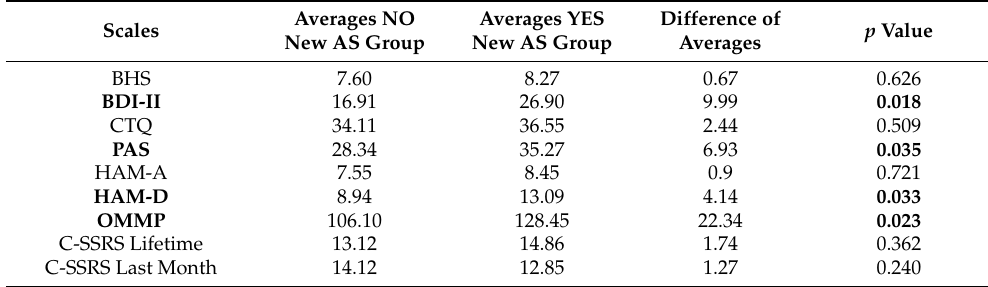
Table 2. Averages of psychometric scales’ scores associated with the risk of new AS and differences between the two